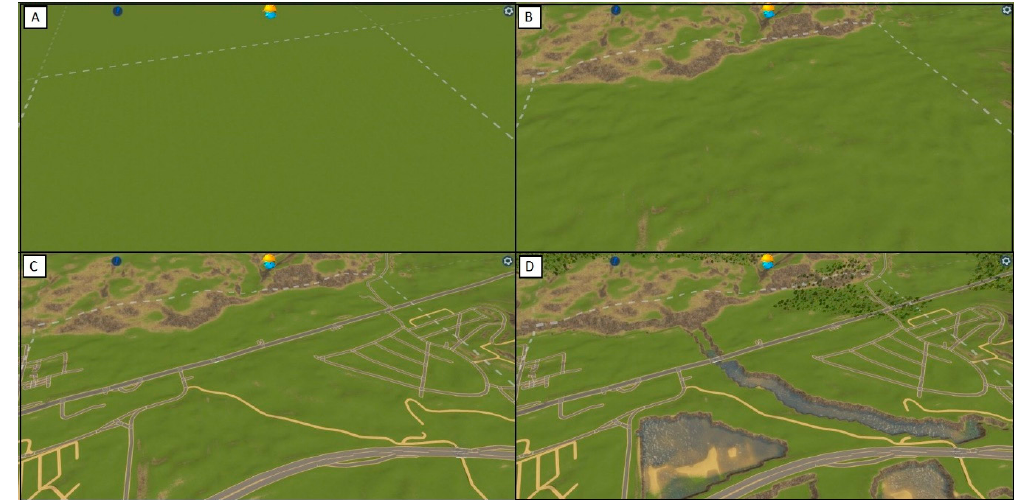
Figure 4. Creation of the base model of Svit from geographical data using the GeoSkylines methods.